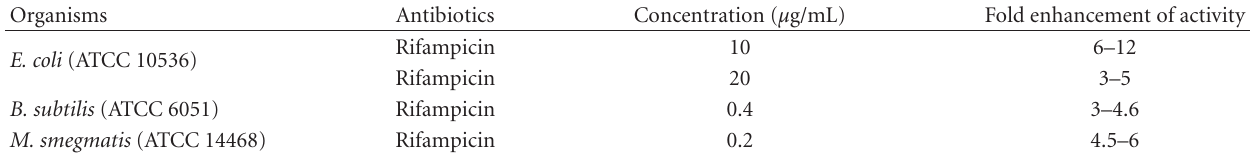
Table 26: Enhancement of antibiotic activity by lysergol (10 μ g/mL) in combination with rifampicin against di ff erent organisms [2]. Organisms